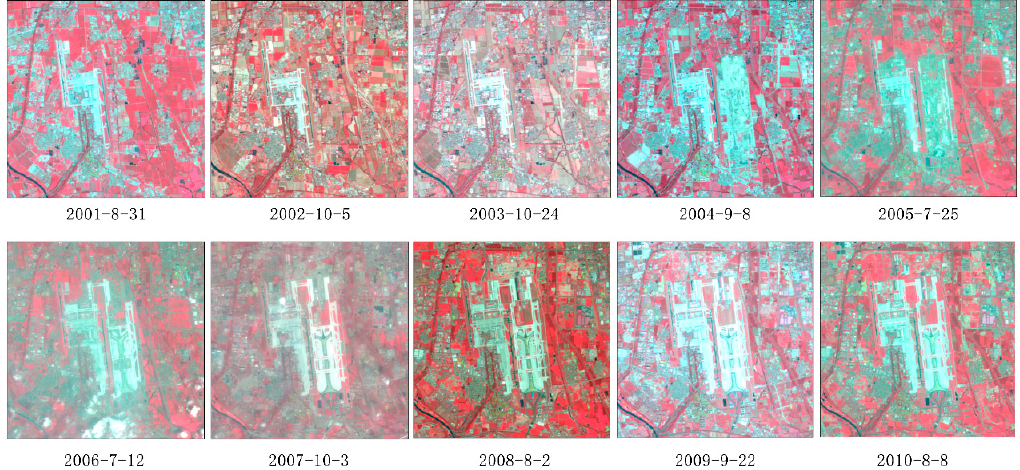
Figure 4. Landsat-5 TM images used for sample collection.